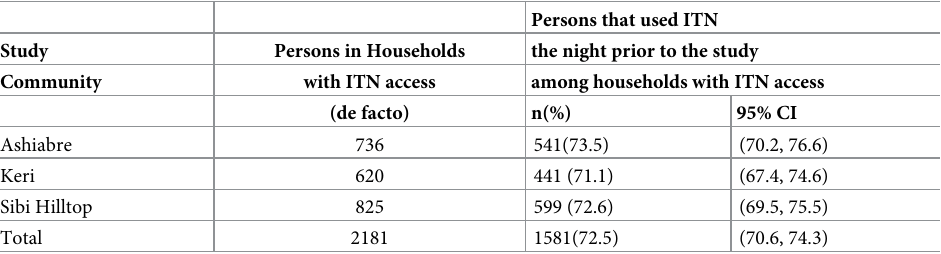
Table 9. Use of ITNs by members of households having a minimum of one ITN for every two